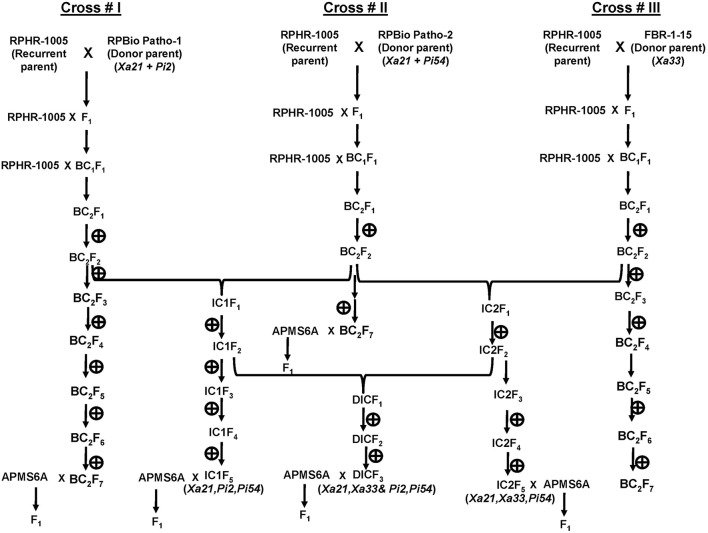
Schematic illustration of the crossing scheme for marker-assisted introgression of Xa21, Xa33, Pi2, and Pi54 into the genetic background of restorer line RPHR-1005.